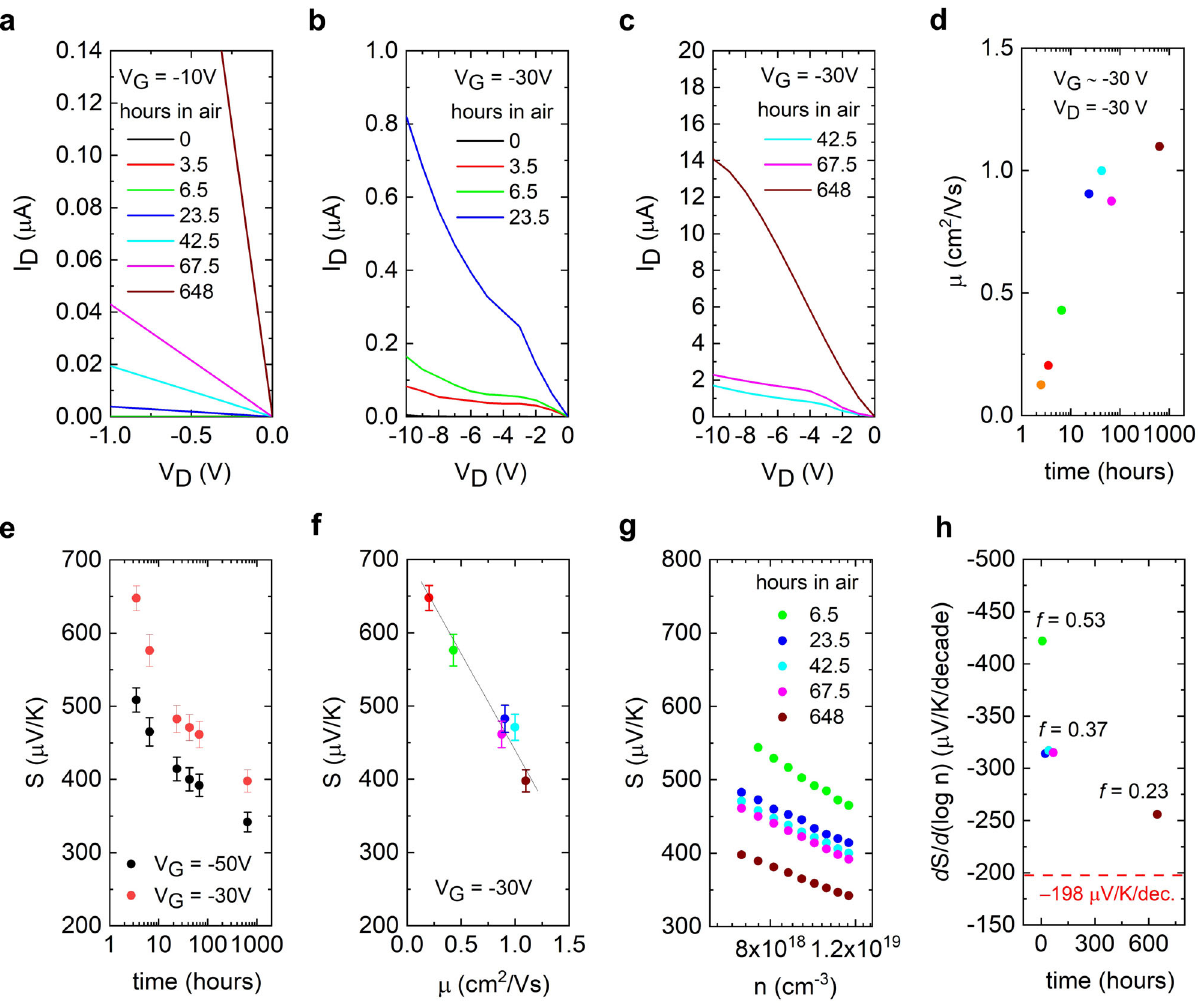
Fig. 3 Parametric dependence of mobility and Seebeck coef fi cient on time. a Output characteristics around V D = 0 V for low gate voltage of V G = – 10 V. b Output characteristics for intermediate drain voltages V D = 0 V to V D = – 10 V, high gate voltage of V G = – 30 V, and for up to one day in ambient air. c Output characteristics for intermediate drain voltages V D = 0 V to V D = – 10 V, high gate voltage of V G = – 30 V, and for between 2 days and a month in ambient air. ( d ) Time evolution of the saturation mobility in the transistor. e Time evolution of the Seebeck coef fi cient in the transistor channel. f Parametric dependence of saturation mobility and Seebeck coef fi cient on time over three temporal decades in hours ( g ) Seebeck coef fi cient vs.